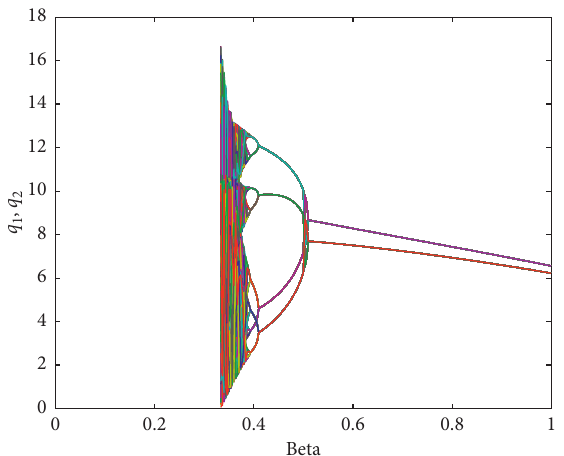
Figure 9: Bifurcation diagram for game (12) as a function of control parameter β when k � 0 . 9.